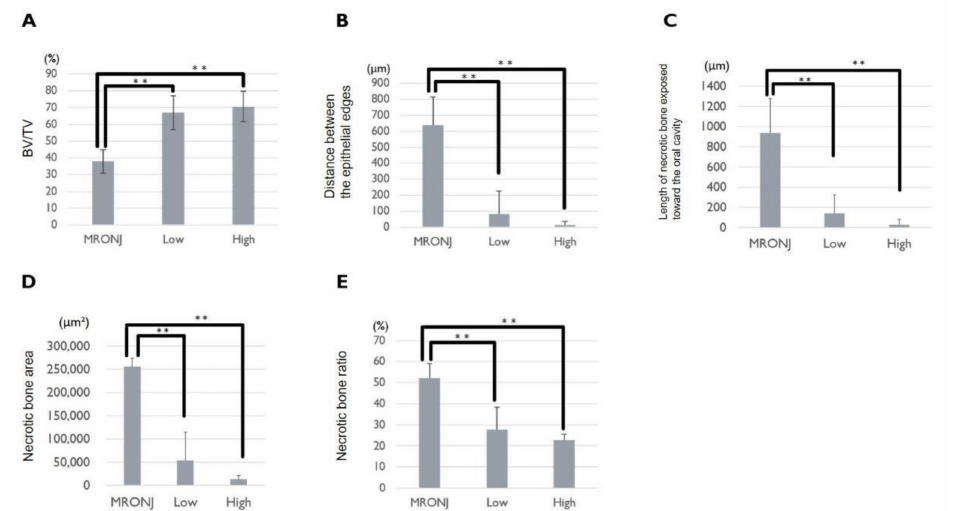
Figure 3. Five variables for evaluating the therapeutic effect of BD on MRONJ-like lesions. In the MRONJ, low, and high groups, the ( A ) BV/TV, ( B ) distance between the epithelial edges, ( C ) length of necrotic bone exposed toward the oral cavity, ( D ) necrotic bone area, and ( E ) necrotic bone ratio are measured, and statistical analyses are performed (Tukey’s test; **: p <